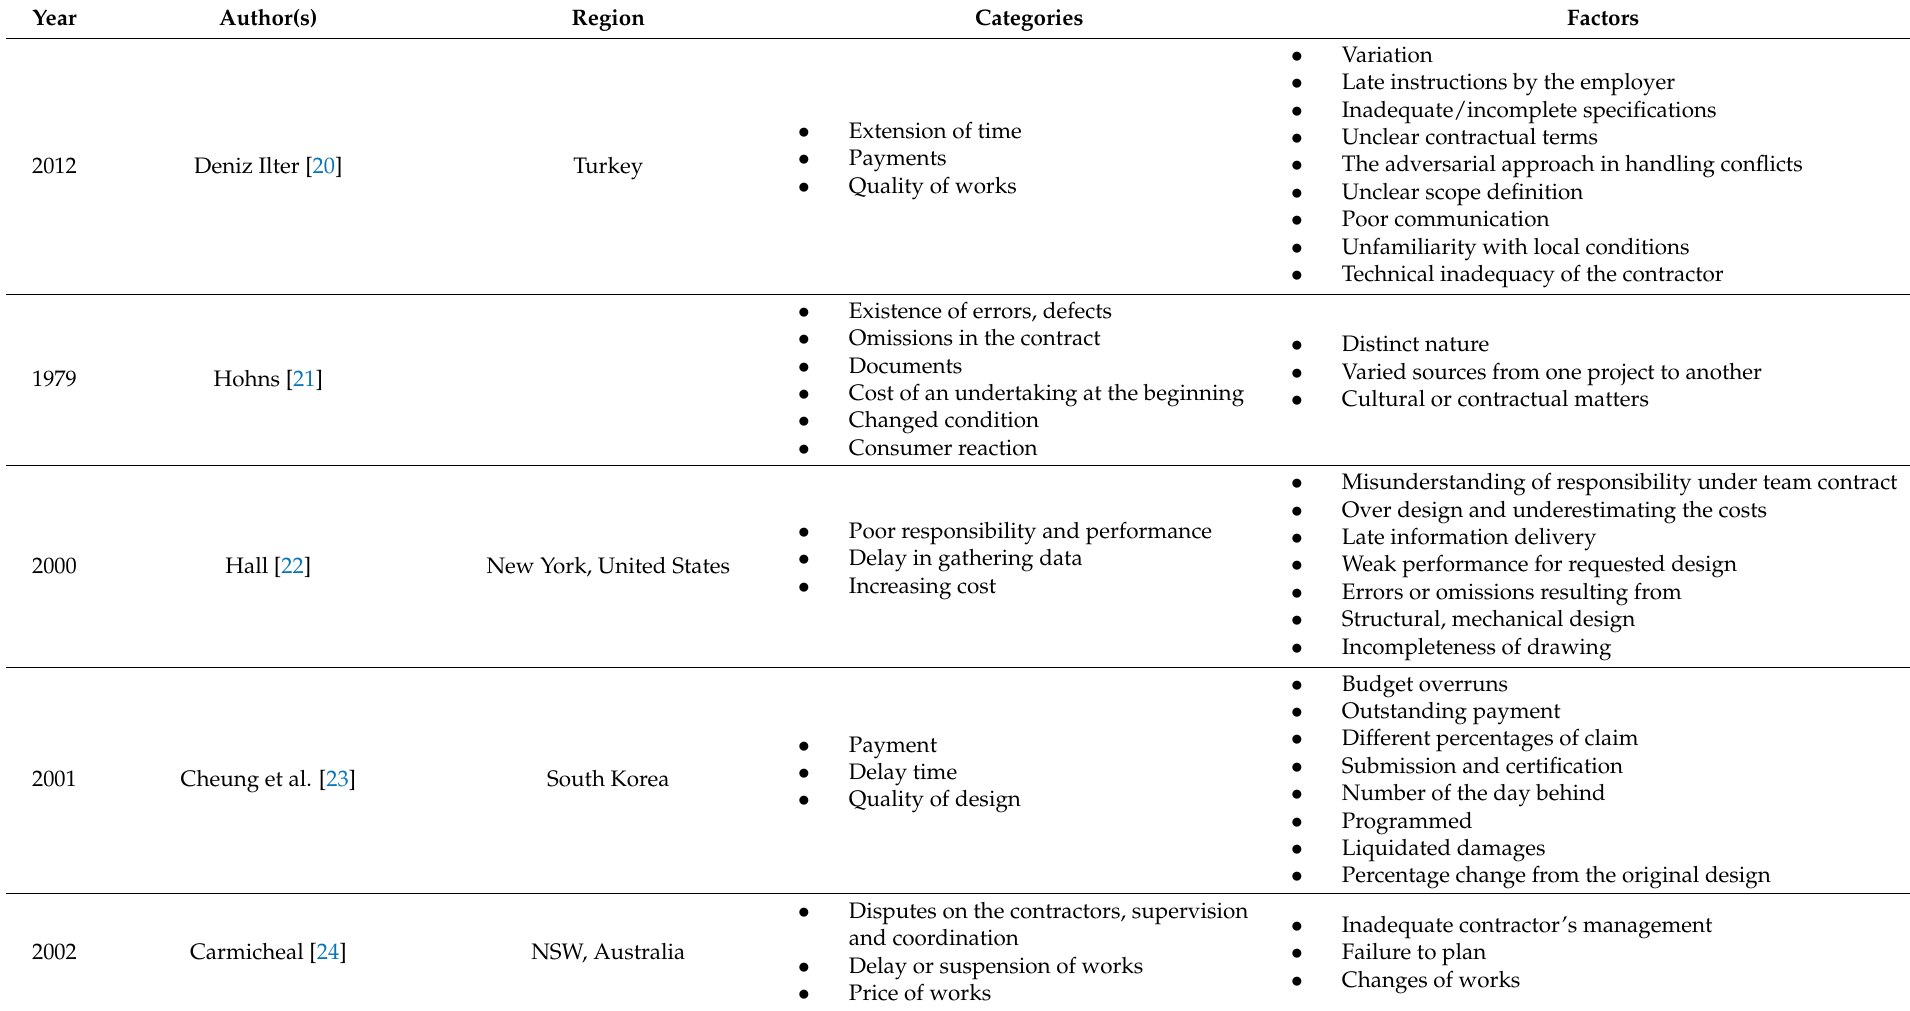
Table 2. Studies on construction dispute factors and